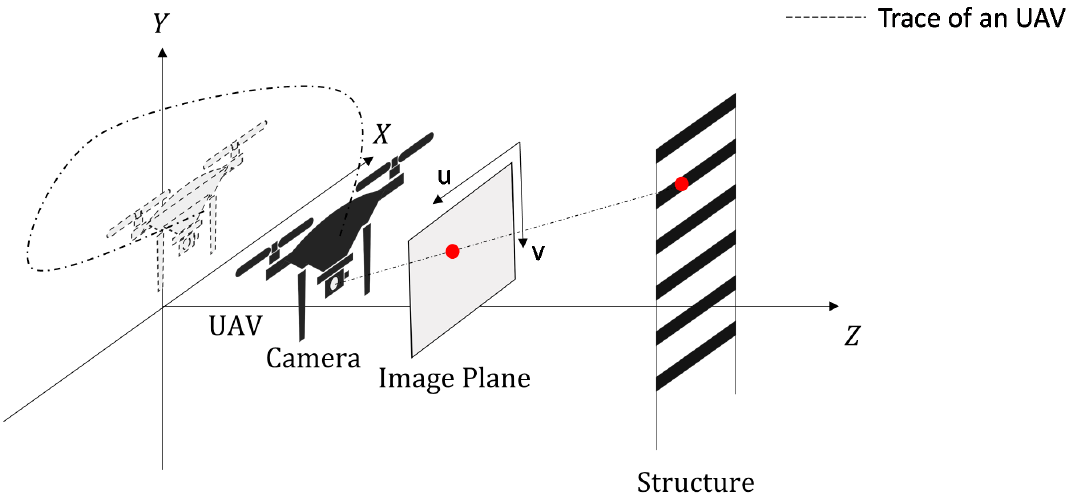
Figure 2. Motion of the UAV with respect to a target structure.